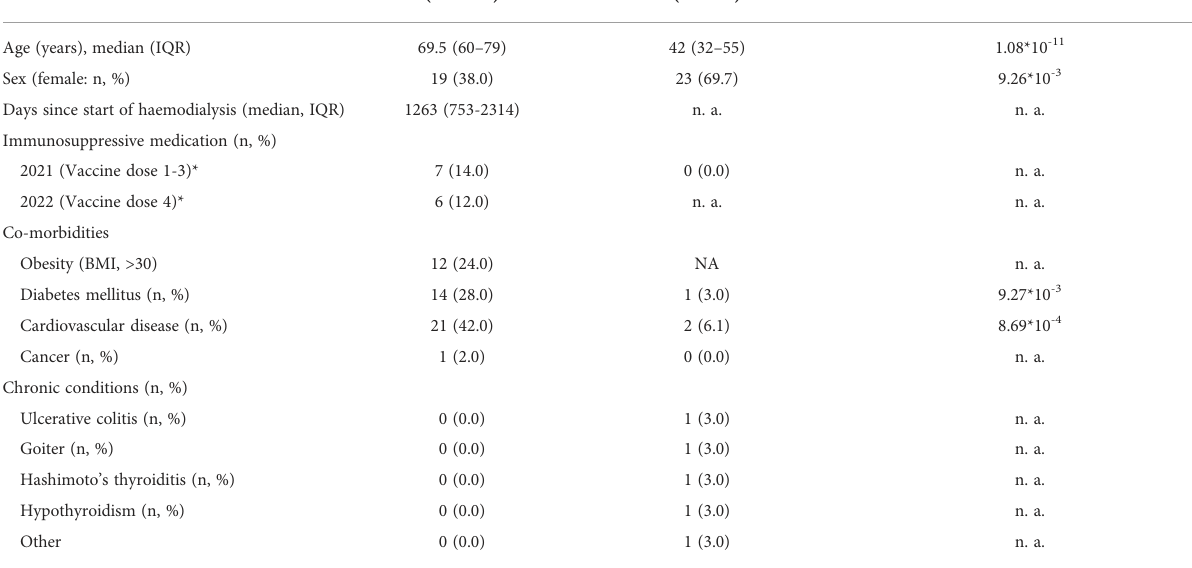
TABLE 1 Characteristics of study population.